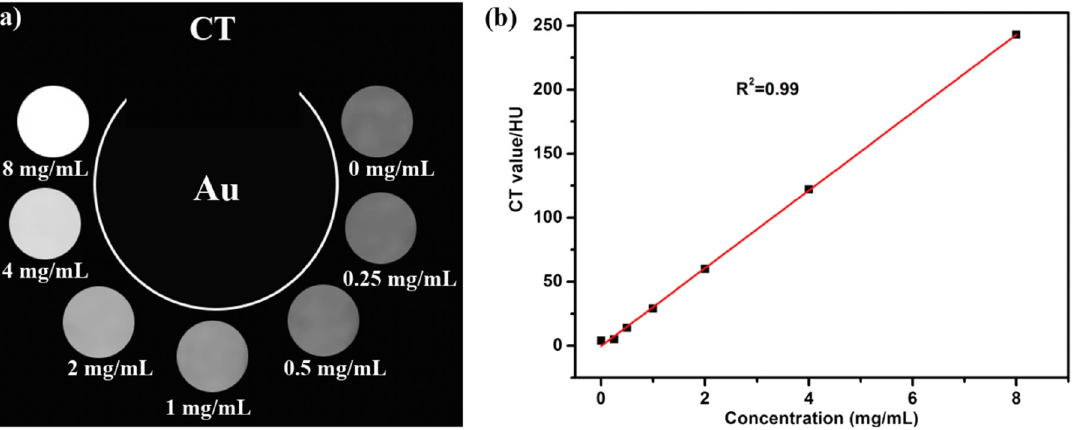
Figure 14. ( a ) CT images for different GNS-FA concentration; ( b ) Hounsfield values dependent on the AuNSs concentrations. Reprinted (adapted) with permission from [153], Copyright 2021 Amer- AuNSs concentrations. Reprinted (adapted) with permission from [167], Copyright 2021 American ican Chemical Society. Chemical